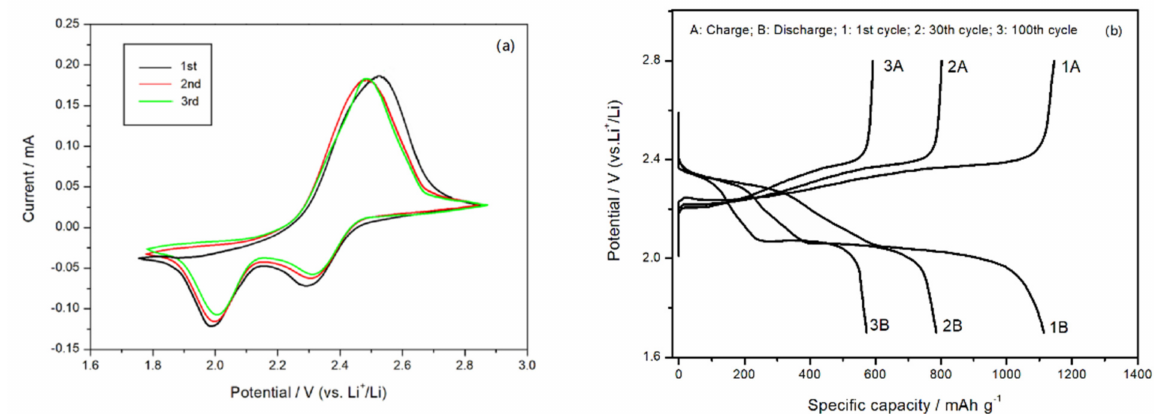
Figure 6. ( a ) CV curves of poly (AN–Ag–S) composite cathode material; ( b ) the charge–discharge curves of poly (AN–Ag– S) composite.